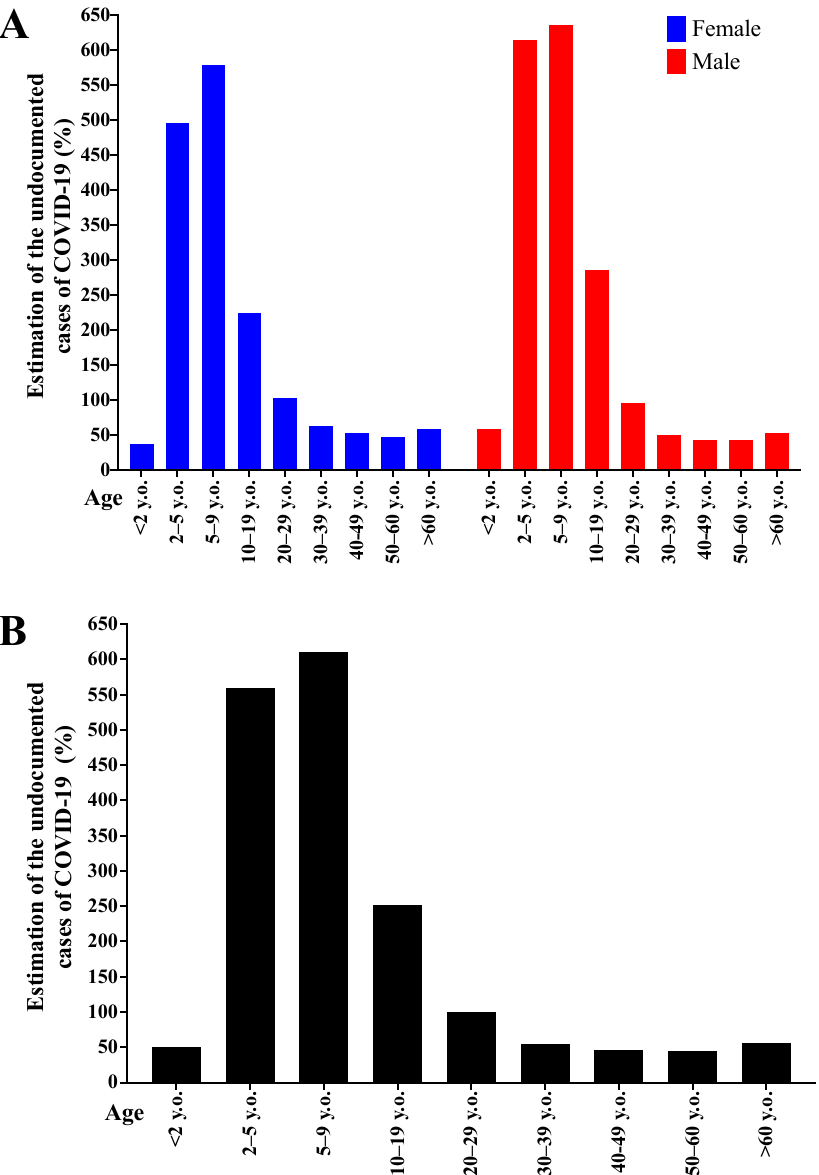
Figure 5. Relative number comparing the number of severe acute respiratory syndrome (SARS) cases with Coronavirus Disease (COVID-19) underdiagnosis and the number of COVID-19 cases per patients’ sex and age group. The data are presented according to sex and age ( A ) and according to age only ( B ). The analysis included only data from 2020.